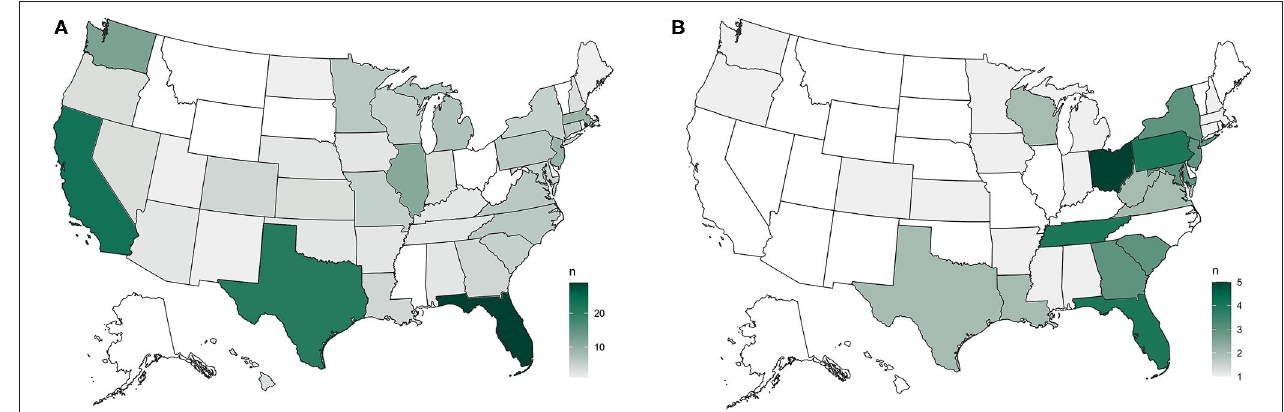
FIGURE 4 | (A) Just over half of our respondents reported always scanning cats for identification microchips during their TNR process, with a distribution similar to our sample as a whole. (B) There was a regional trend among organizations that reported never scanning cats for microchips, revealing this practice is largely an East Coast